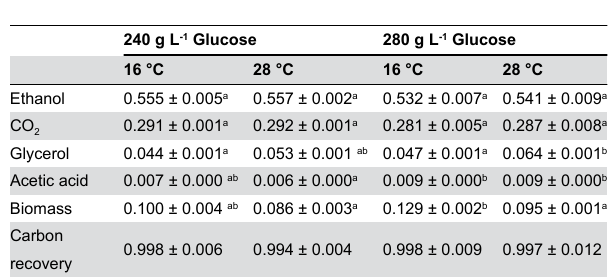
Table 1. Yields on glucose (C-mol C-mol -1 glucose) for the main metabolites resulting from anaerobic continuous cultures.